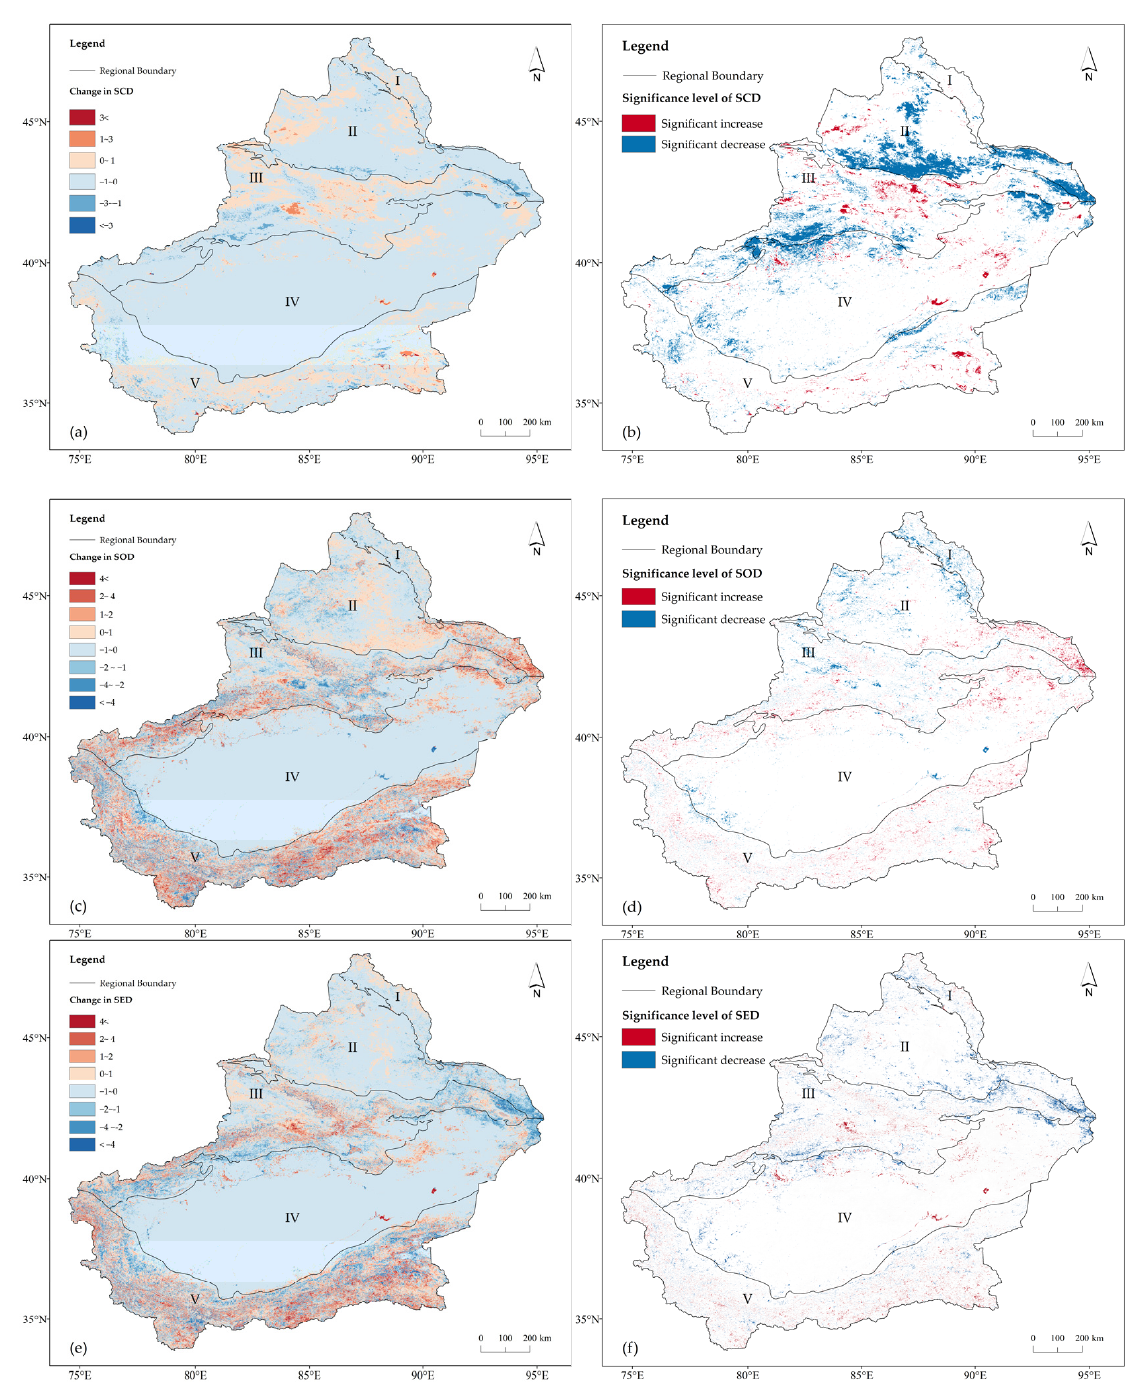
Figure 9. Changes and significance levels of snow cover in Xinjiang during 2001–2020: SCD ( a , b ); SOD ( c , d ); and SED ( e , f ).